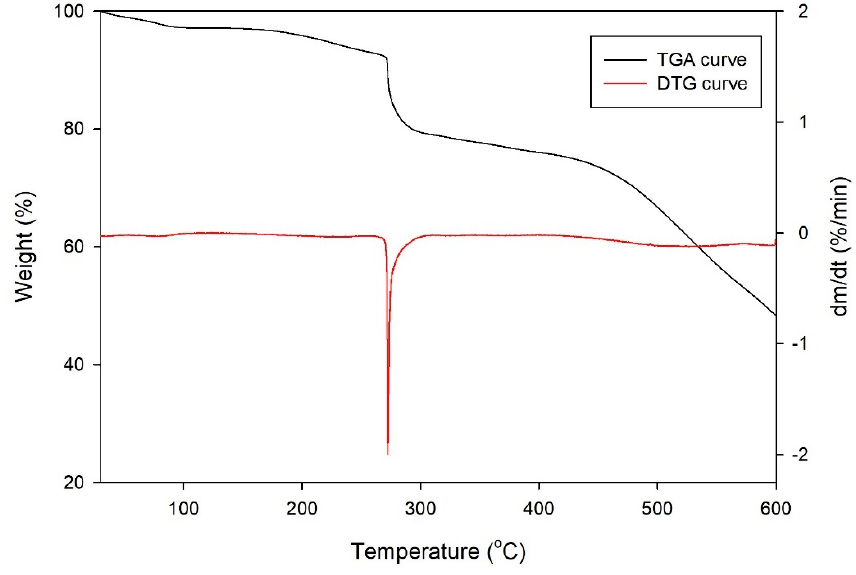
Figure 10. TGA and DTG curves of ZIF-L.